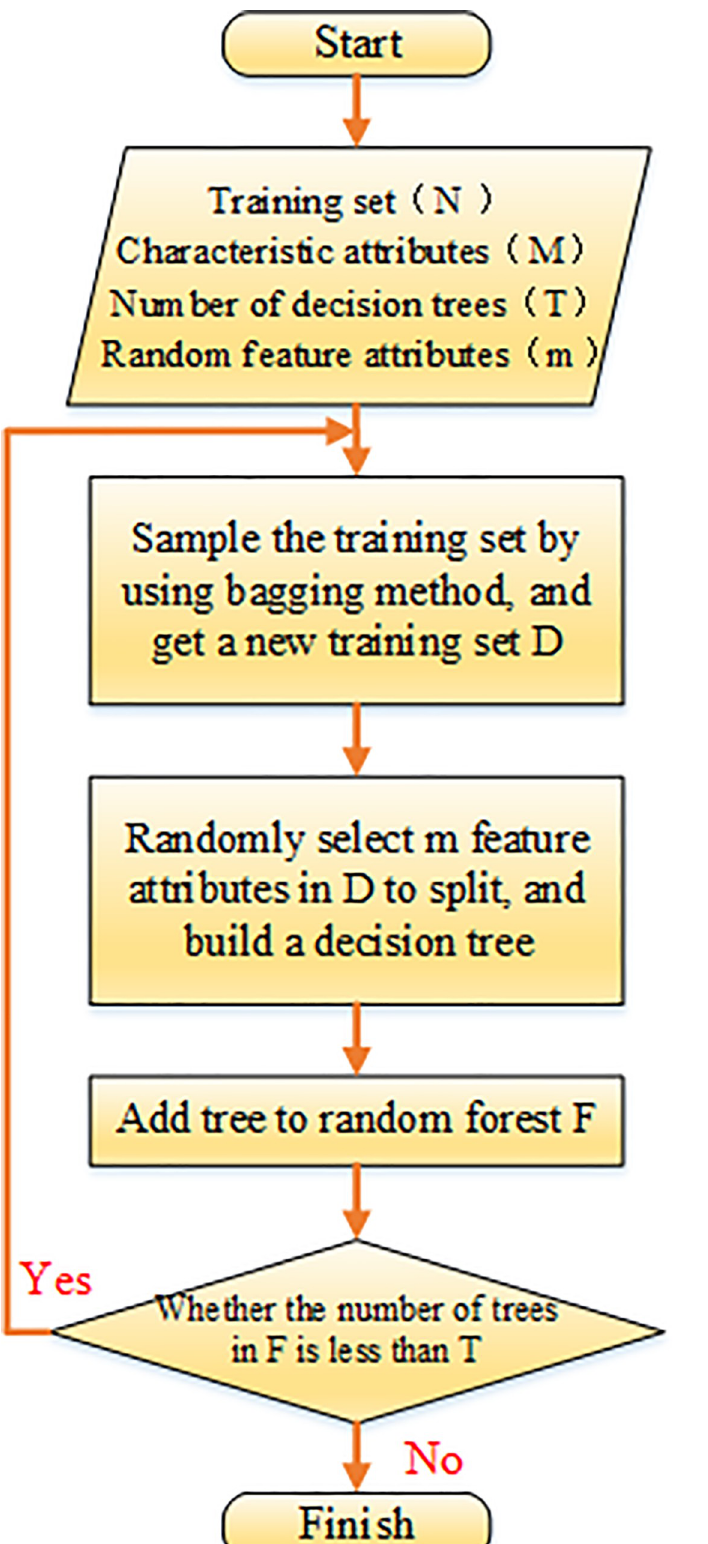
Fig 7. Flow chart of generating random forest